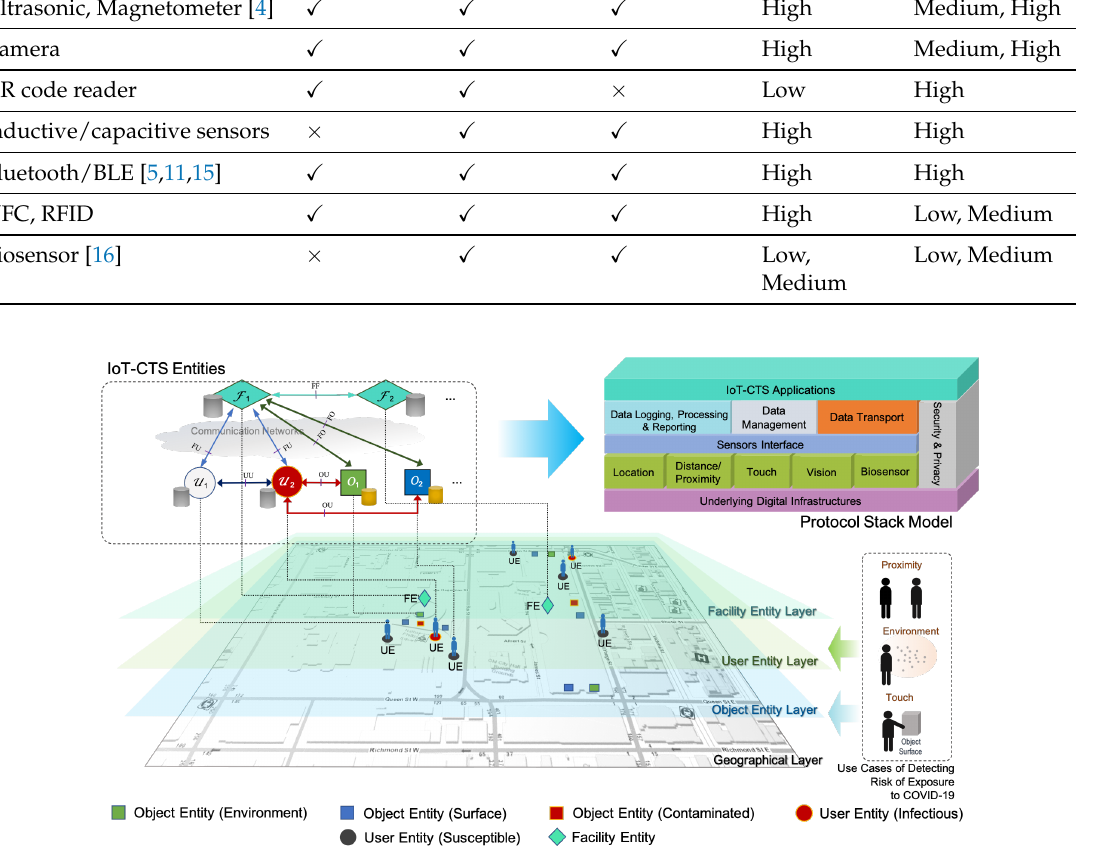
Figure 1. An IoT-CTS